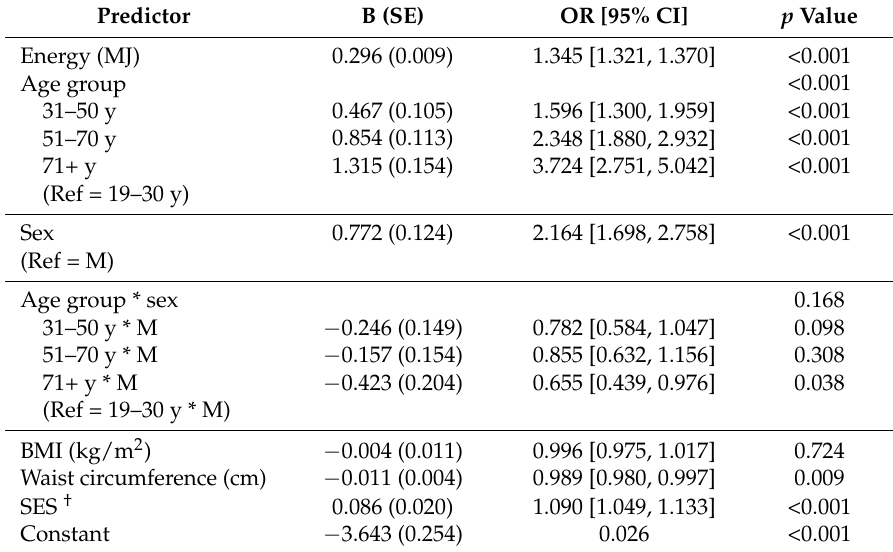
Table 4. Binary logistic regression analysis of predictors of meeting fibre AI * among adults aged 19 years and over.